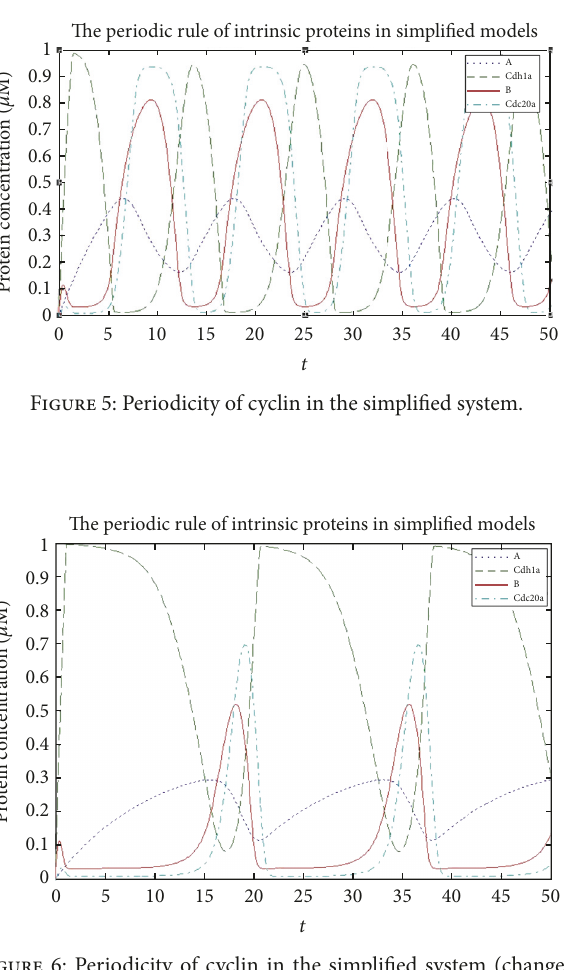
Figure 6: Periodicity of cyclin in the simplified system (changed internal